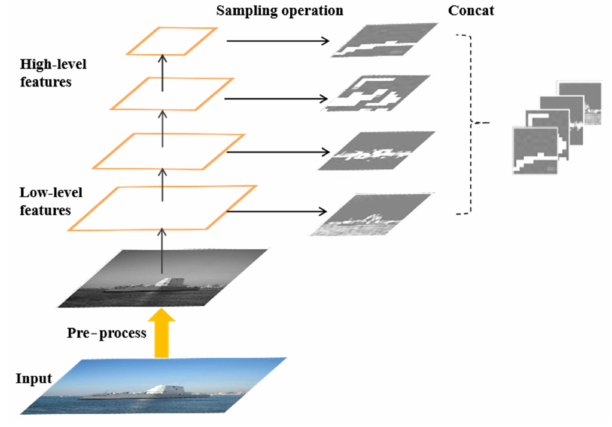
Figure 9. Feature fusion diagram of our FF-SqueezeNet middle layer.